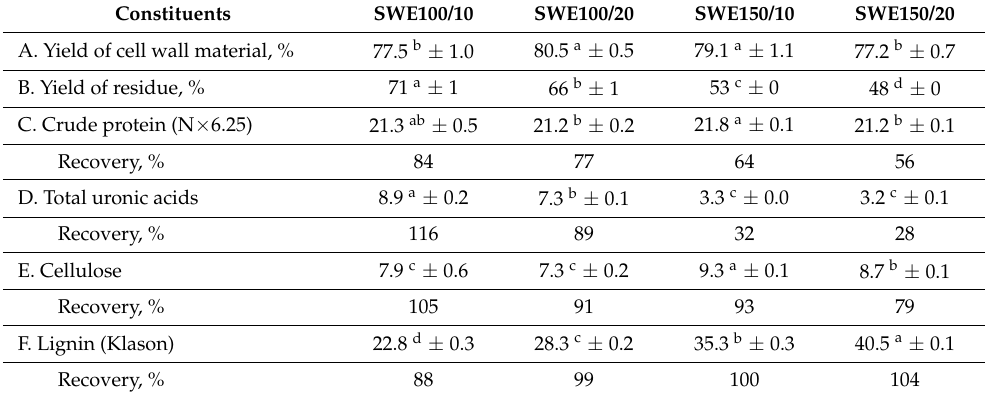
Table 3. Yield and chemical characterization of residue after subcritical water extraction ( w / w